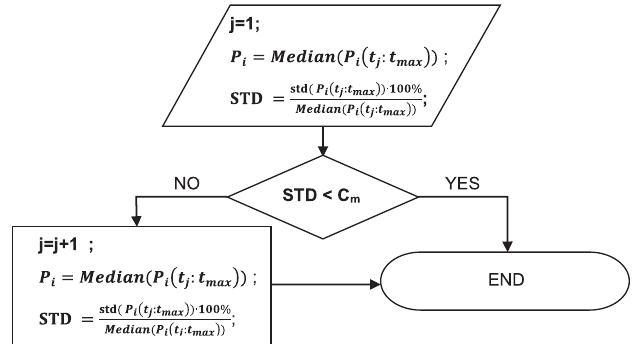
Fig. 1. The fl owchart of the iterative method to obtain the time integrated absolute power of